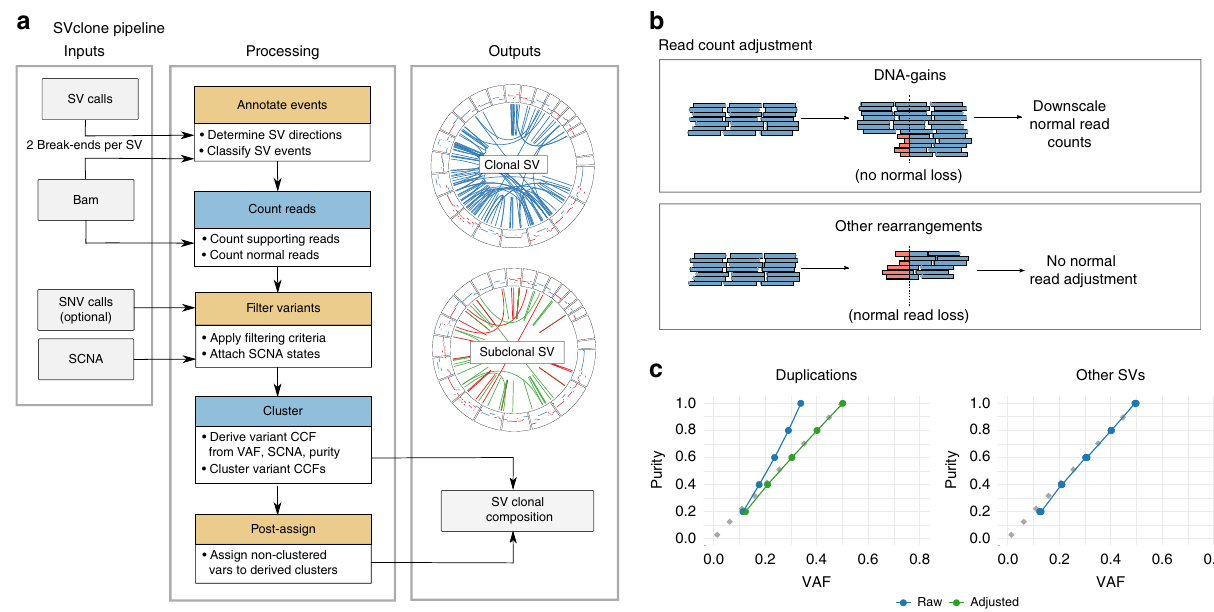
Fig. 1 Pipeline schematic and VAF calculation adjustment. a A fl ow-chart of the SVclone pipeline. b A schematic showing the adjustments required for DNA-gains (top) and all other rearrangements (bottom). From left to right, each segment shows an unaffected locus, the effect of the variant type on reads at the breakpoint, and the resulting adjustment strategy required to normalise the allele frequency. Red portions of the reads show soft-clips, i.e. the portion of the reads mapping to the other end of the breakpoint. c The effect of adjusting raw VAFs in duplications (left), and unadjusted VAFs for other SVs (right), at purity levels at 20 – 100% in 20% increments, where the expected VAF is half the purity level (dotted